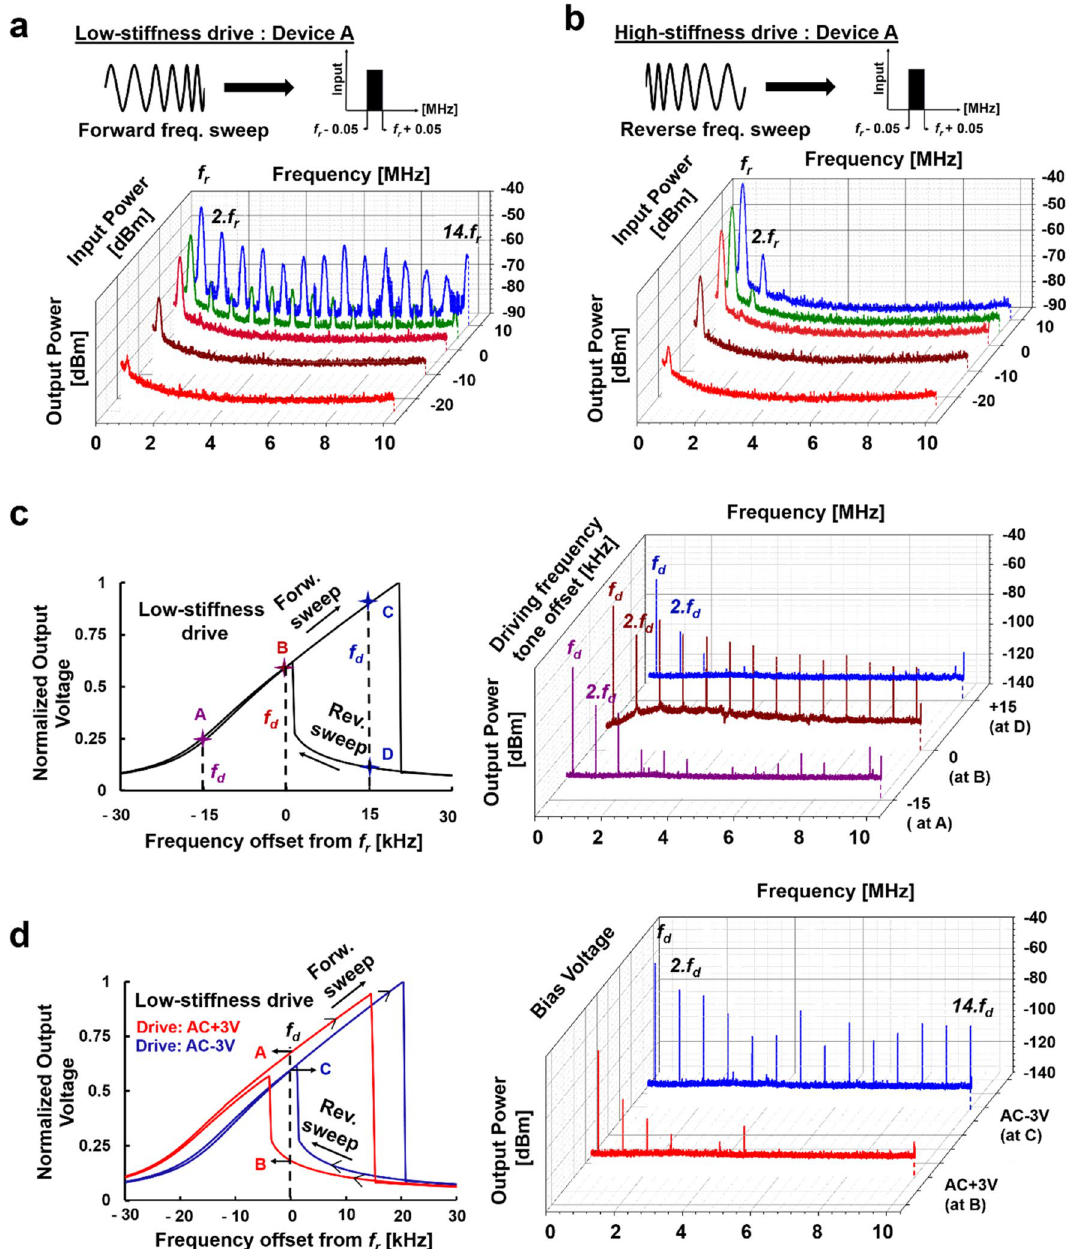
Figure 5. Fully electrically interfaced HHG control schemes. ( a ) and ( b ) are the output spectra for Device A operating in the high and degenerate nonlinear regime respectively for an input frequency sweep of f r ± 50 kHz. For this HHG study, the input AC signal sweep has a definite bandwidth and is not a single tone. ( c ) The output voltage plot for a bidirectional frequency sweep of the resonator along f r ± 30 kHz is presented and output voltages corresponding to three frequencies are identified. For the single tone based HHG control, when the device is driven at each of these frequencies different harmonic outputs are attained. The count and the strength of the harmonics directly correspond to the output voltage at f d . ( d ) The output voltage plot for a bidirectional frequency sweep of the resonator along f r ± 30 kHz is presented for different DC bias voltage. The frequency shift is DC voltage polarity dependent; hence for different DC bias voltages, different counts of harmonics can be achieved for the same f d